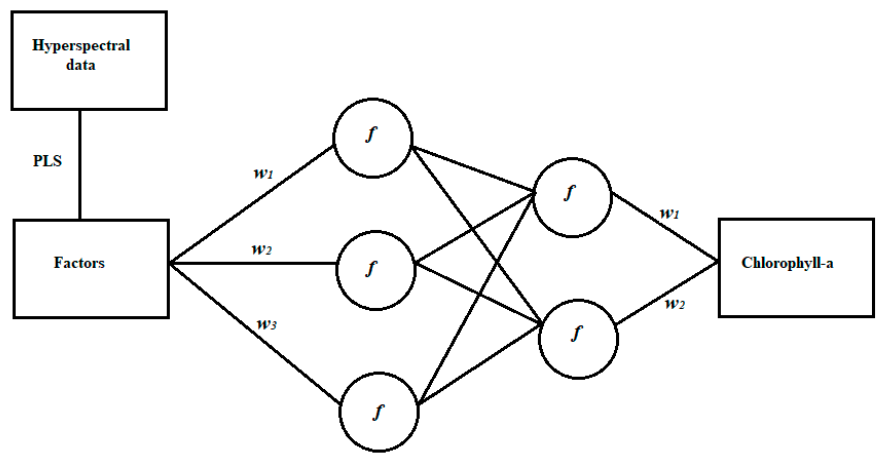
Figure 6. Optimized PLS-ANN algorithm.